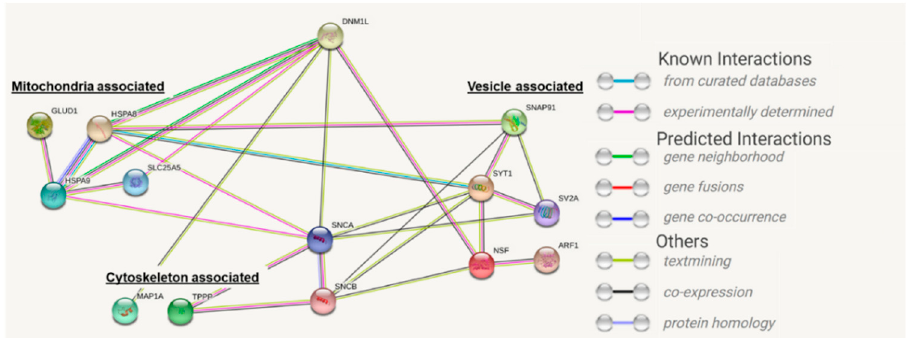
Figure 8. STRING protein interaction network. Analysis of the signaling pathway altered by the anti-DNM1L Ab injection. Search tool for the retrieval of interacting proteins (STRING) shows the signaling pathways of the most significantly changed proteins using the medium confidence score (0.4). The target protein of the study, DNM1L, was added manually to the network. The network showed significantly altered proteins ( p < 0.05, student’s t -test) identi- fied in the MS analysis. The target protein of this study, DNM1L, was not identified as significantly different in the present MS analysis and was manually added to determine possible interactions with the significantly changed marker protein.